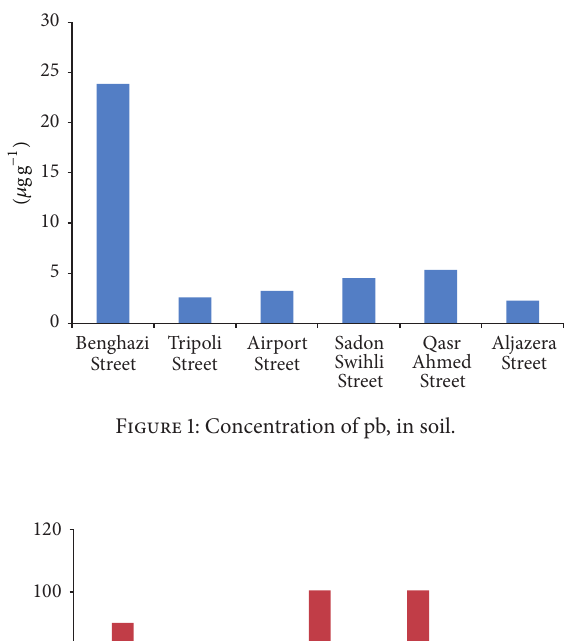
Figure 3: Concentration of Cd, Cr, and Cu in